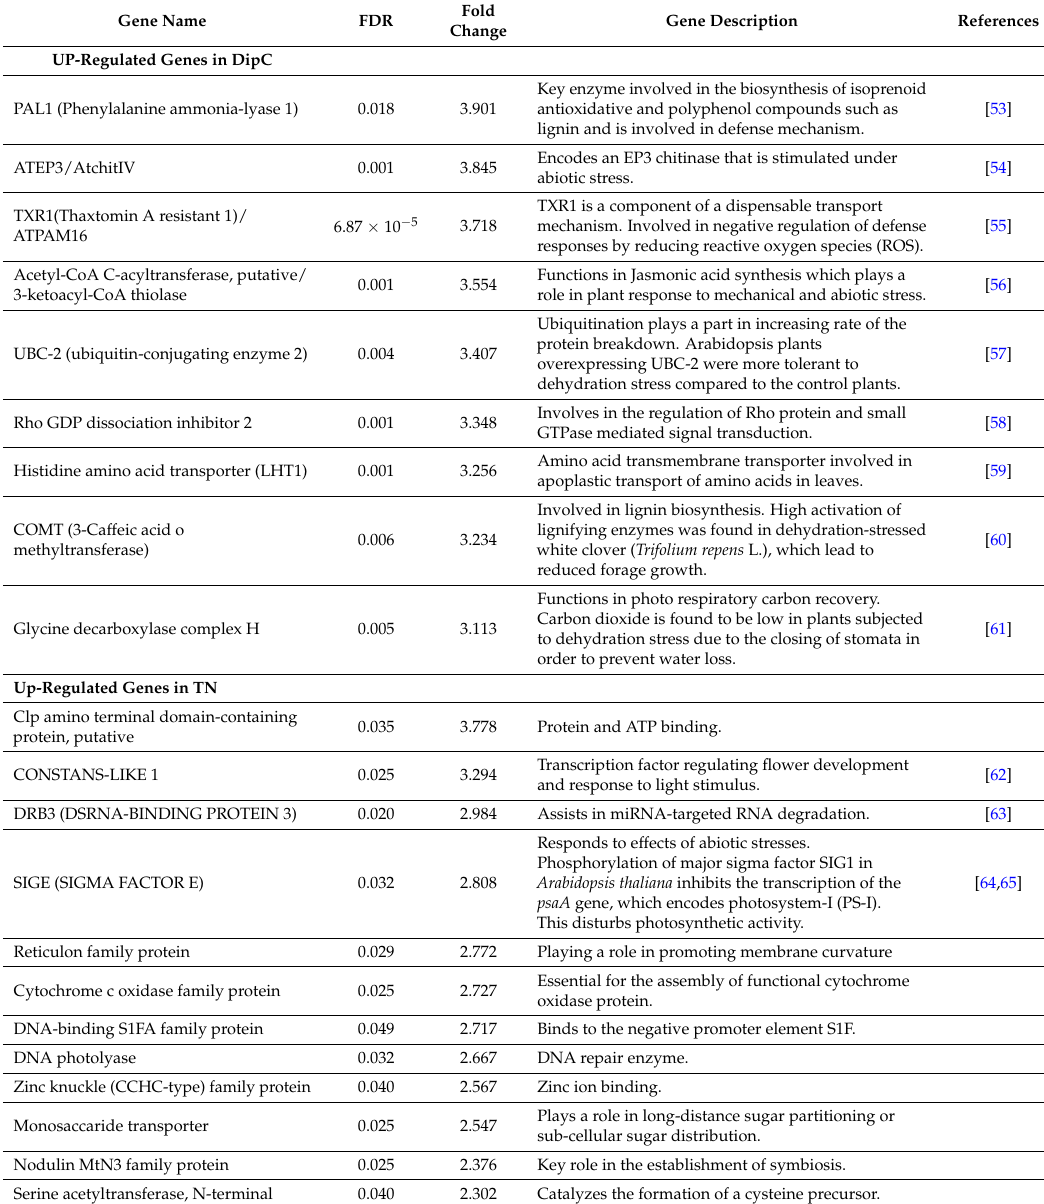
Table 3. Top upregulated genes in DipC and